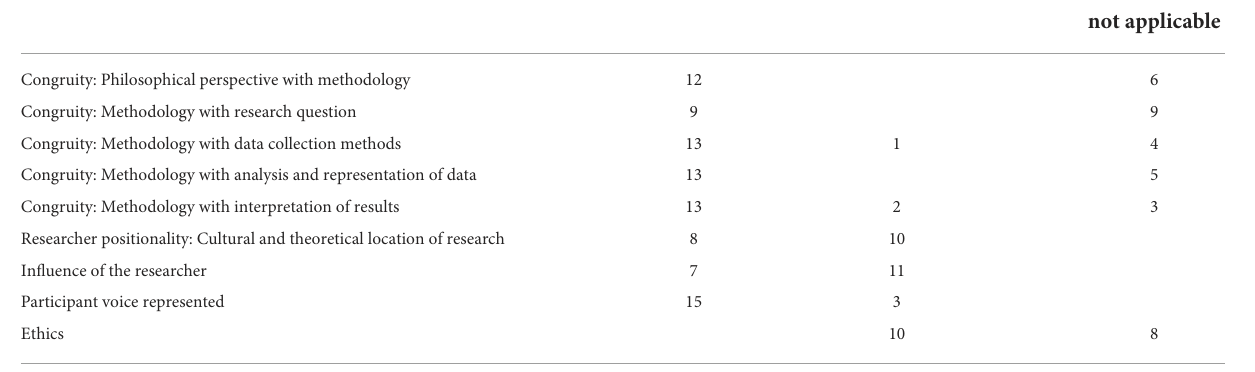
TABLE 5 Critical appraisal—methodological